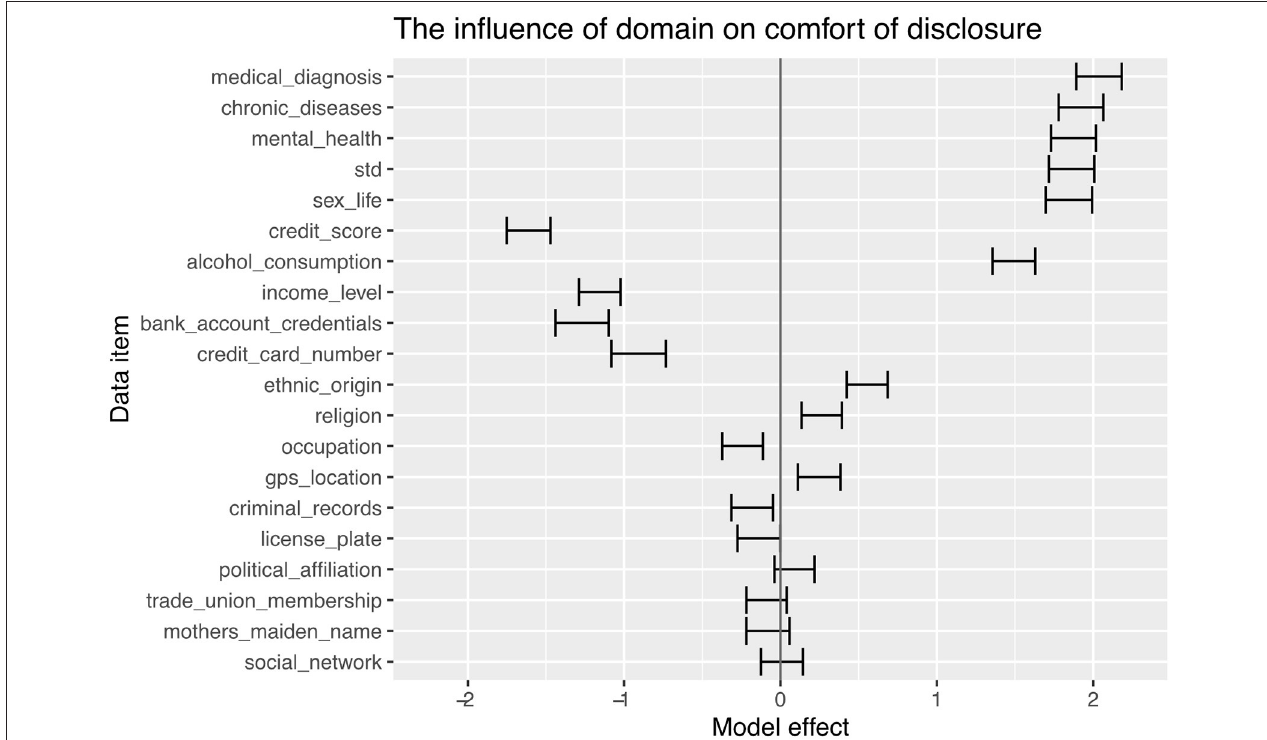
FIGURE 5 | The influence of